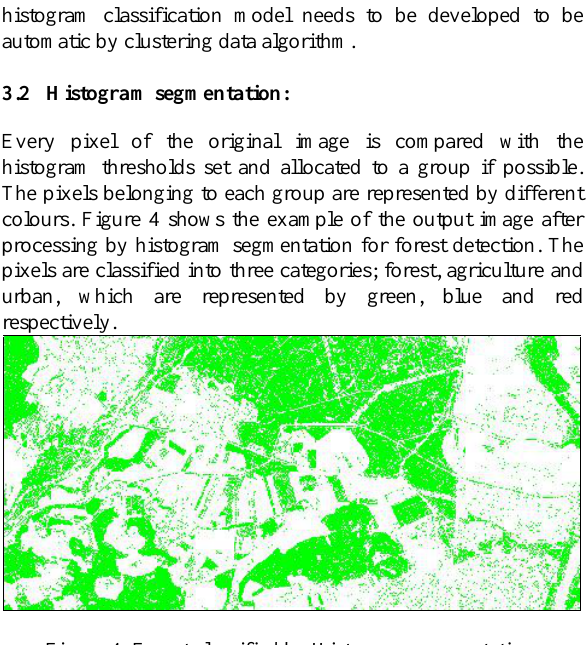
Figure 4. Forest classified by Histogram segmentation.